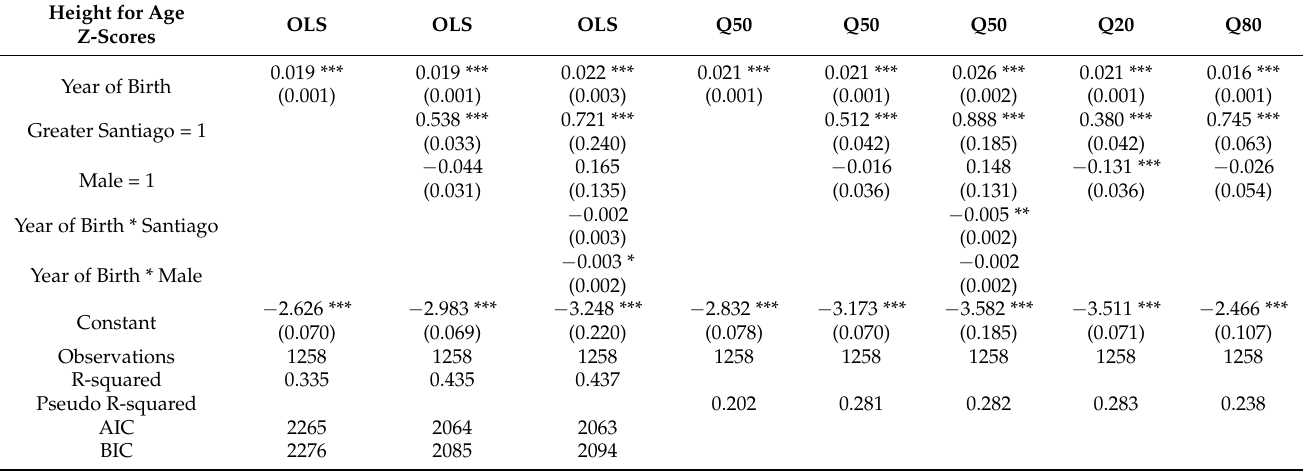
Table 5. OLS and quantile regressions on HAZ scores, Chilean boys and girls, cohorts 1887–2001. Height for Age OLS Z-Scores